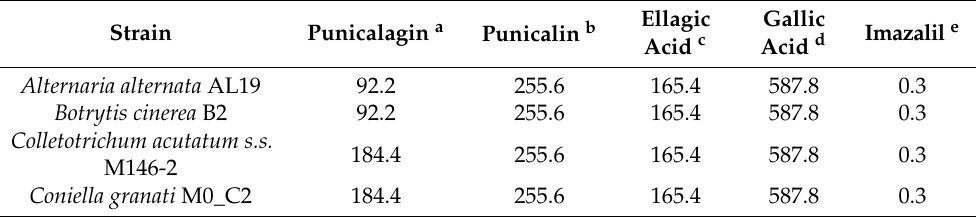
Table 1. Minimum inhibitory concentration (MIC) of punicalagin, punicalin, ellagic acid, gallic acid and imazalil (fungicide positive control). Data are expressed as µ M. Ellagic Gallic Strain Punicalagin a Punicalin b Imazalil e Acid c Acid d Alternaria alternata AL19 92.2 255.6 165.4 587.8 0.3 Botrytis cinerea B2 92.2 255.6 165.4 587.8 0.3 Colletotrichum acutatum s.s. 184.4 255.6 165.4 587.8 0.3 M146-2 Coniella granati M0_C2 184.4 255.6 165.4 587.8 0.3 Tested concentrations: a 92.2–368.8 µ M; b 127.8–511.2 µ M; c 165.4–661.8 µ M; d 587.8–2351.3 µ M; e Label